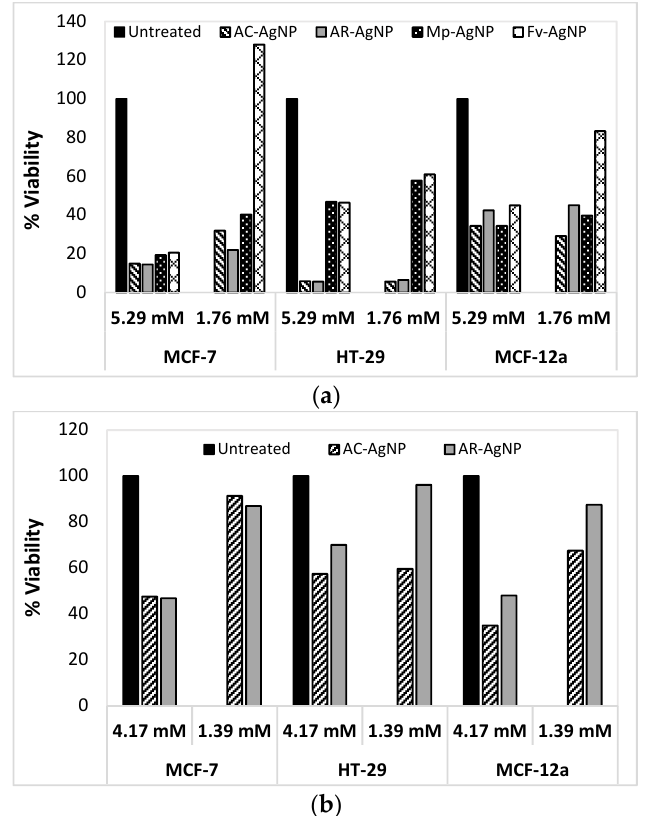
Figure 11. Percentage cell viability for MCF-7, HT-29 and MCF-12a cell lines after 24 h with ( a ) AgNPs and ( b ) AuNPs. AC: Aqueous extract subjected to organic solvent partitioning. AR: simple aqueous extraction.